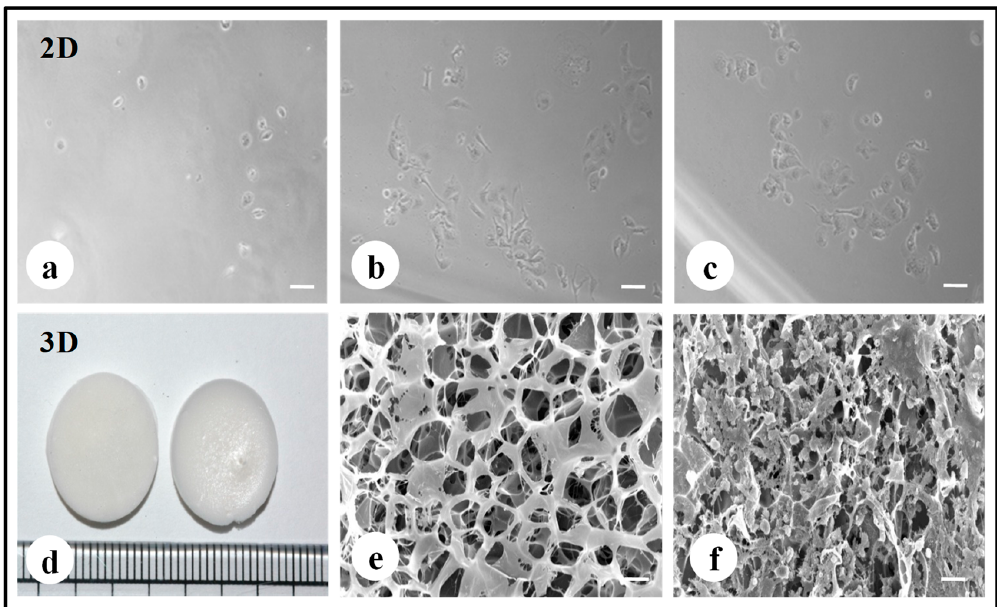
Figure 1. Fabrication of silk 2D and 3D silk constructs. ( a ) A. mylitta silk fibroin 2D construct seeded with